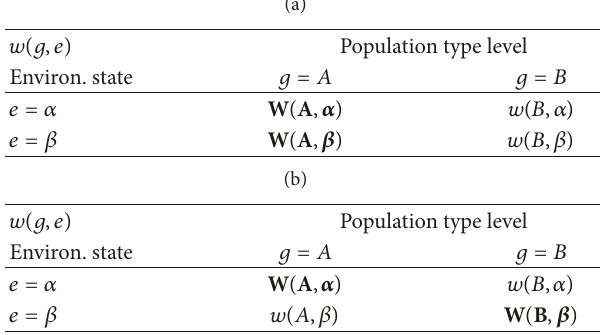
Table 1: Fitness landscapes in matrix form with types 𝑔 and environmental states 𝑒 and corresponding fitness values 𝑤(𝑔, 𝑒) . The larger fitness value of the binary type split (horizontal) is denoted with capital letter 𝑊 and the less fit of the two with the small letter 𝑤 . Despite this simple case of two types, the covariance relation of (2) also holds also for more than two types. (a) schematizes a positive covariance between type fitness in environments 𝑒 = 𝛼 and 𝑒 = 𝛽 , while (b) schematizes a negative covariance, with superior type fitness along the diagonal of the